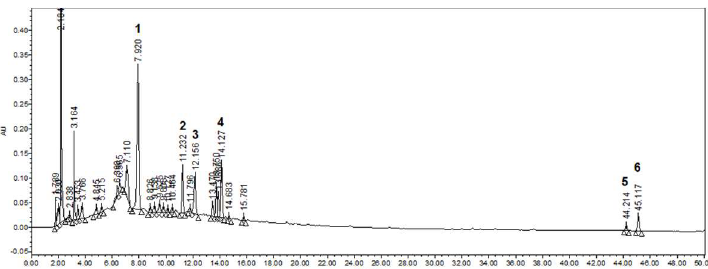
3 of 16 barrier function parameters including pH, hydration, and transepidermal water loss (TEWL) were also measured. Skin pH and TEWL were increased in the DNCB compared with the normal group, and CQ treatment decreased skin pH and TEWL levels compared with the DNCB group (Tables 1